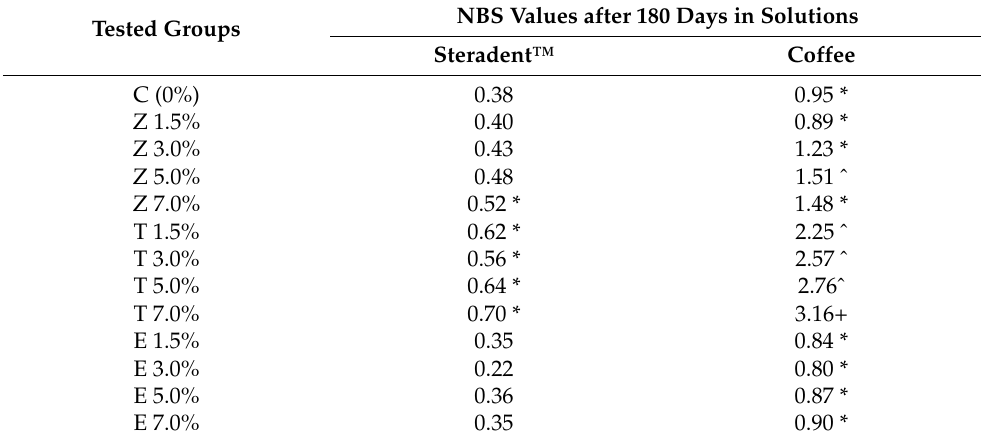
Table 6. Colour change values according to the NBS unit system after storing the specimens in different solutions for 180